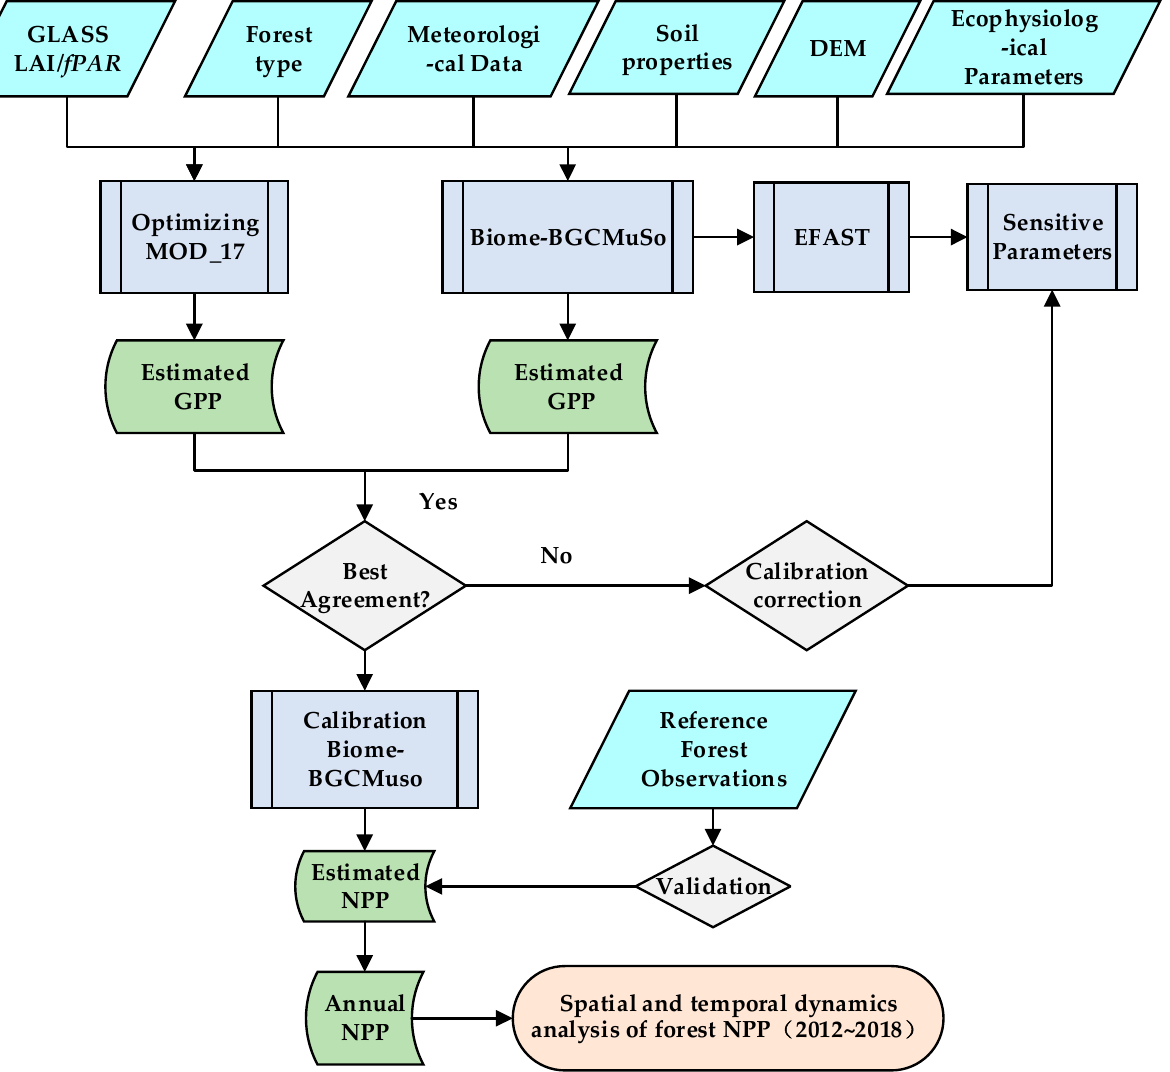
Figure 2. Overall flow chart of this study.